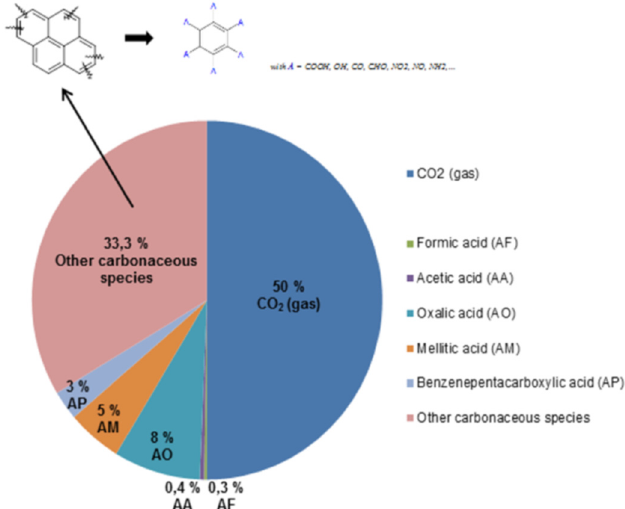
Fig. 5. Carbon speciation during UC